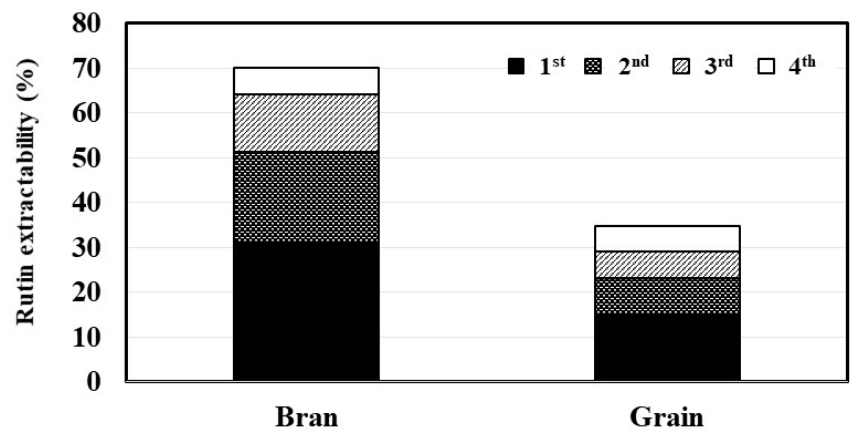
Figure 3. The rutin extractability of roasted Tartary buckwheat bran and grain in each infusion test. The data are averages of four determinations.